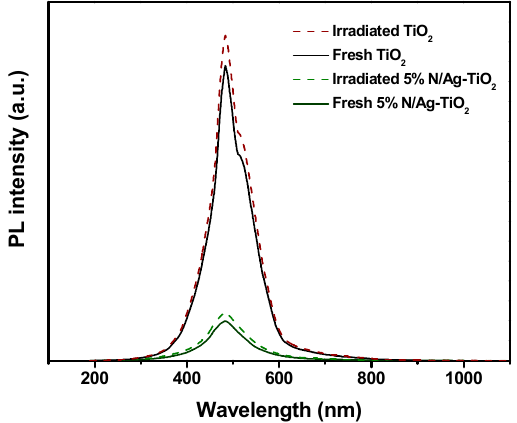
Figure 9. PL emission spectra of 5% N/Ag-TiO 2 and TiO 2 before and after visible LED irradiation.